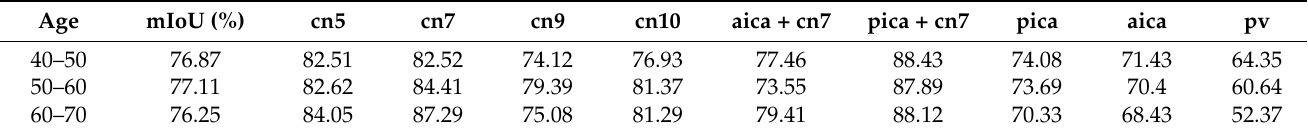
Table 9. Accuracy comparison for different age groups on the MVD test set.